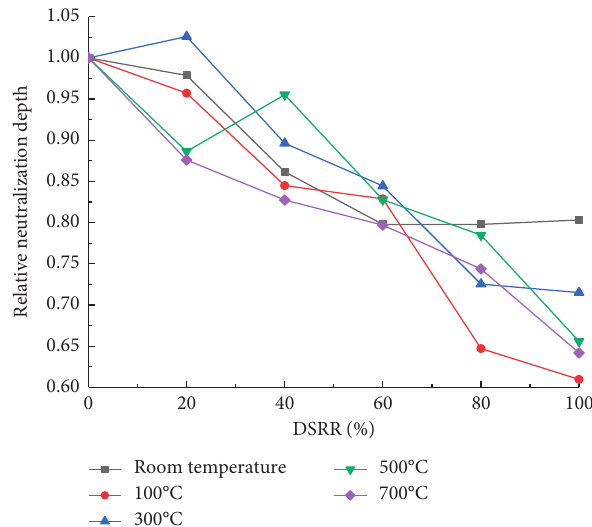
Figure 22: Relation between relative neutralization depth and